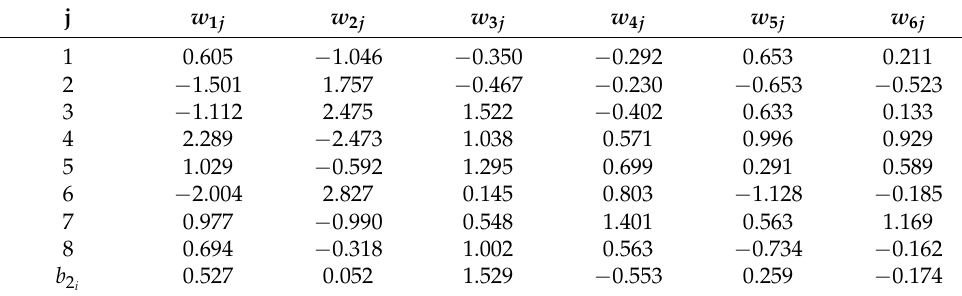
Table 8. Constant values of weights and bias for output layer.